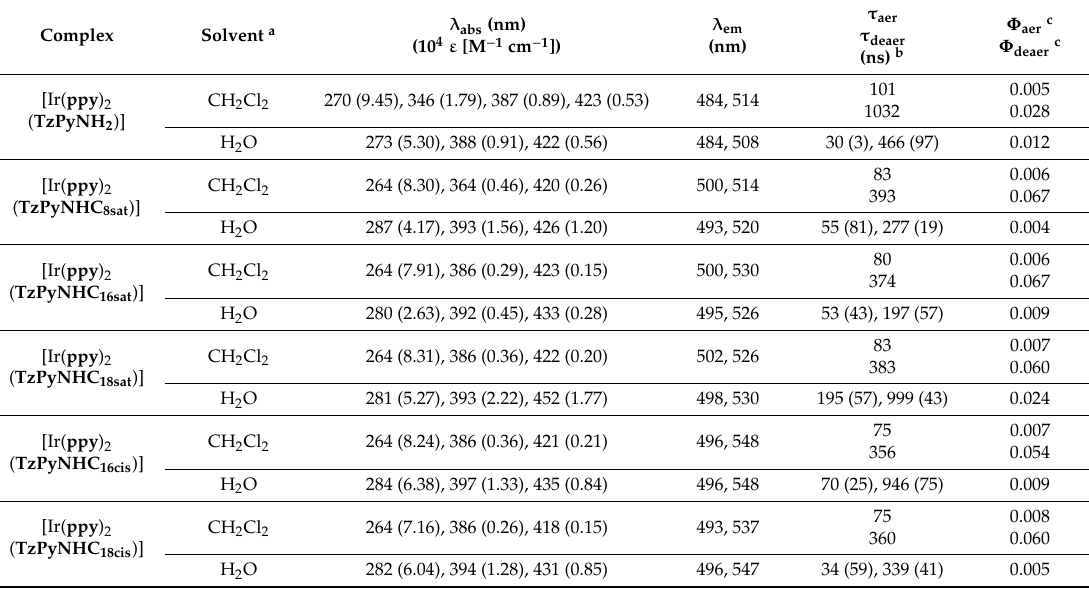
Table 1. Photophysical data of the reported iridium complexes from air-equilibrated and